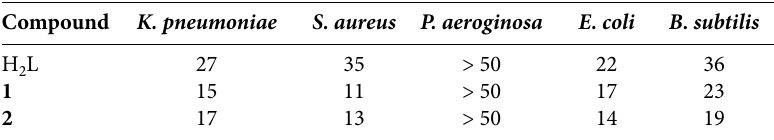
Table 4. Minimum inhibitory concentrations (MICs, μg mL –1 ) of the compounds Compound